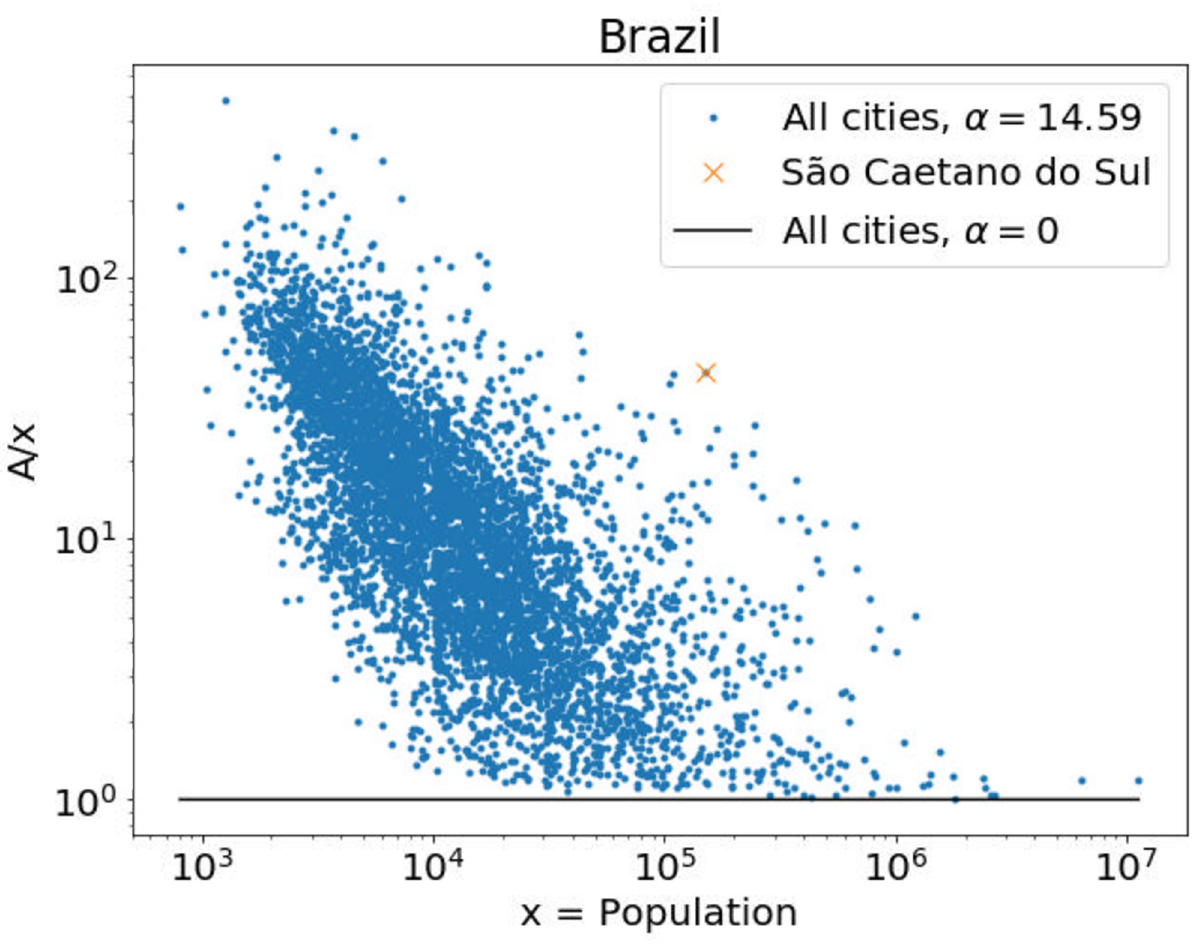
Fig 3. Accounting for spatial interactions increase the attractiveness of individuals in small cities. The attractiveness A population x i is shown as a function of x i for the different Brazilian municipalities i . The horizontal black line correspond to the case in which spatial = x ). The dots correspond to the result of the Gravitational model with the maximum likelihood parameters interactions are ignored ( α = 0 ) A i i obtained for the case of GDP (see Table